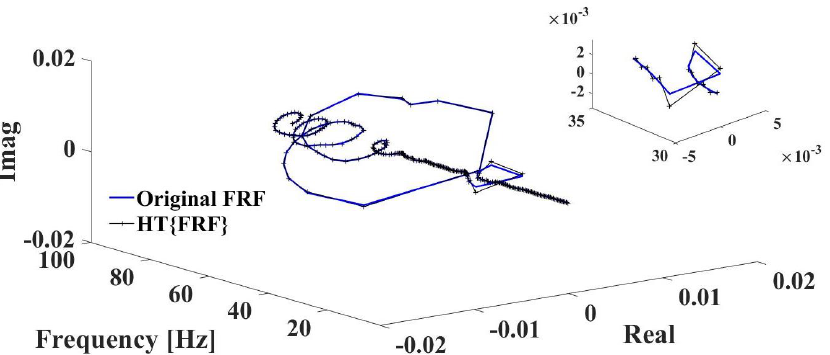
Figure 9. Original FRF (blue line) and its corresponding Hilbert transformation with first mode detail. The Argand diagram of the FRF and its Hilbert transformation is shown in Figure 10, where the original response is depicted in a blue and continuous line. In contrast, the corre- sponding Hilbert transformation is represented in a bold black line.